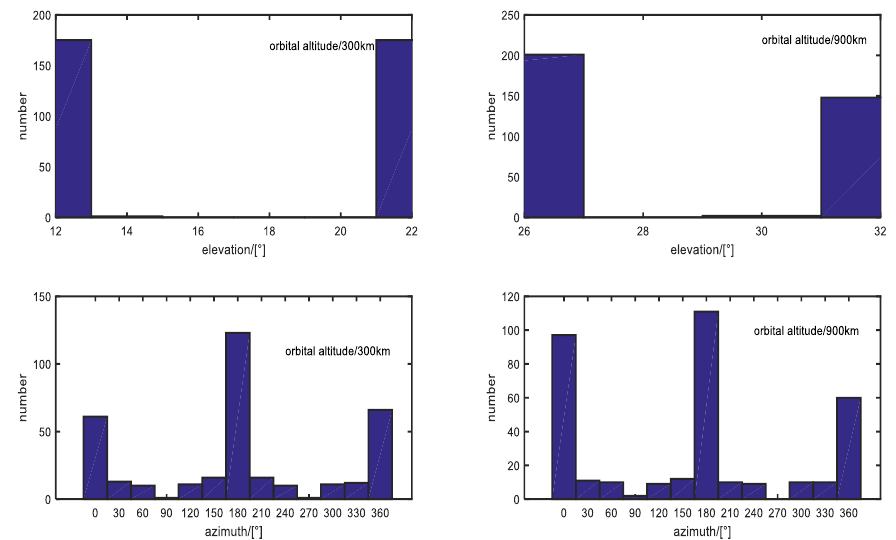
Figure 10. Variations in the elevation and azimuth with orbital altitude.